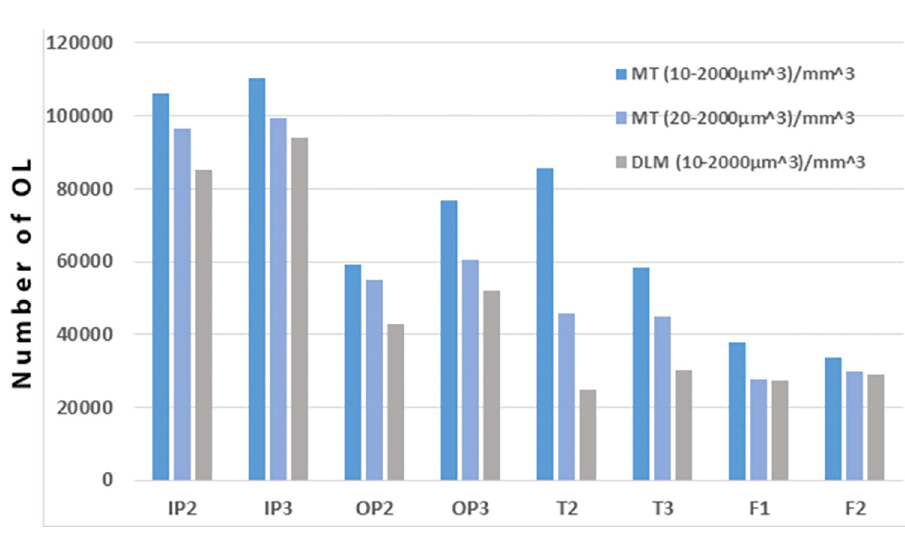
Fig 4. The OL concentration using the two segmentation approaches. Dark blue represents the MT segmentation with volumes from 10–2000 μ m 3 , light blue is the same segmentation method but with volumes from 20–2000 μ m 3 , and grey represents the DLM segmentation for OL volumes between 10–2000 μ m 3